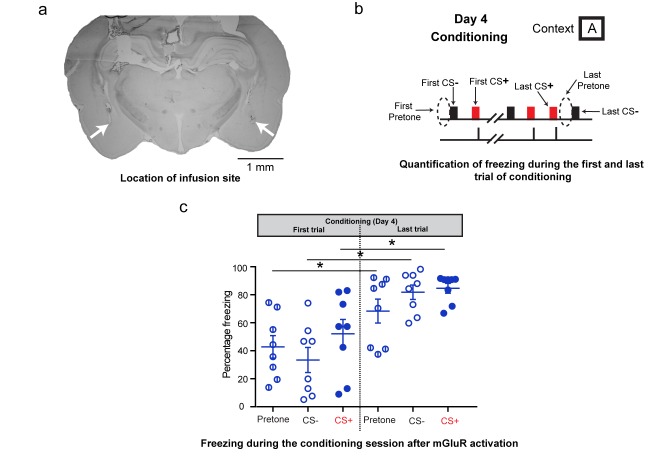
Additional analysis of freezing behavior during differential conditioning after DHPG infusion on Day 4.(a) A sample image showing the location of the infusion cannula. The white arrows denote the tip of the infusion cannula. (b) To assess the effect of mGluR activation on the freezing response during fear conditioning, the freezing response to the first CS+, CS- and the first pretone were analysed. These were compared to the freezing response to the last CS+, CS- and last pretone of the conditioning session. (c) The high level of indiscriminate freezing to CS+/CS-/pretone is visible not only at the beginning of the conditioning, but also at the end. Moreover, the levels of freezing at the end of conditioning show an overall increase for pretone as well as CS+/CS- (*p<0.05). Thus, although the conditioning session leads to enhanced freezing, this freezing continues to be indiscriminate.DOI:
http://dx.doi.org/10.7554/eLife.25665.00810.7554/eLife.25665.009Figure 2—figure supplement 2—source data 1.Data for individual animals representing freezing response to CS+, CS- and pretone during the first and last trial of conditioning after DHPG infusion on day 4 (Figure 2—figure supplement 2c).